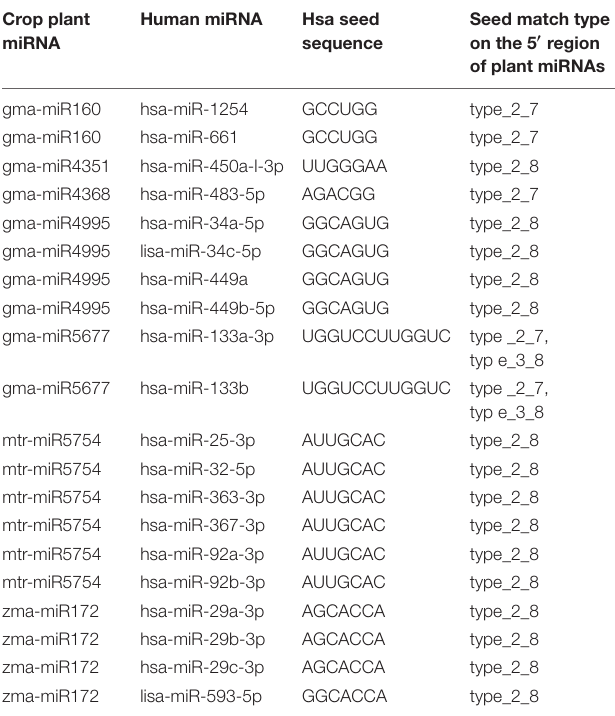
TABLE 1 | Human–plant microRNAs (miRNAs) seed comparison results. Crop plant Human miRNA Hsa seed Seed match type miRNA sequence on the 5 (cid:48)